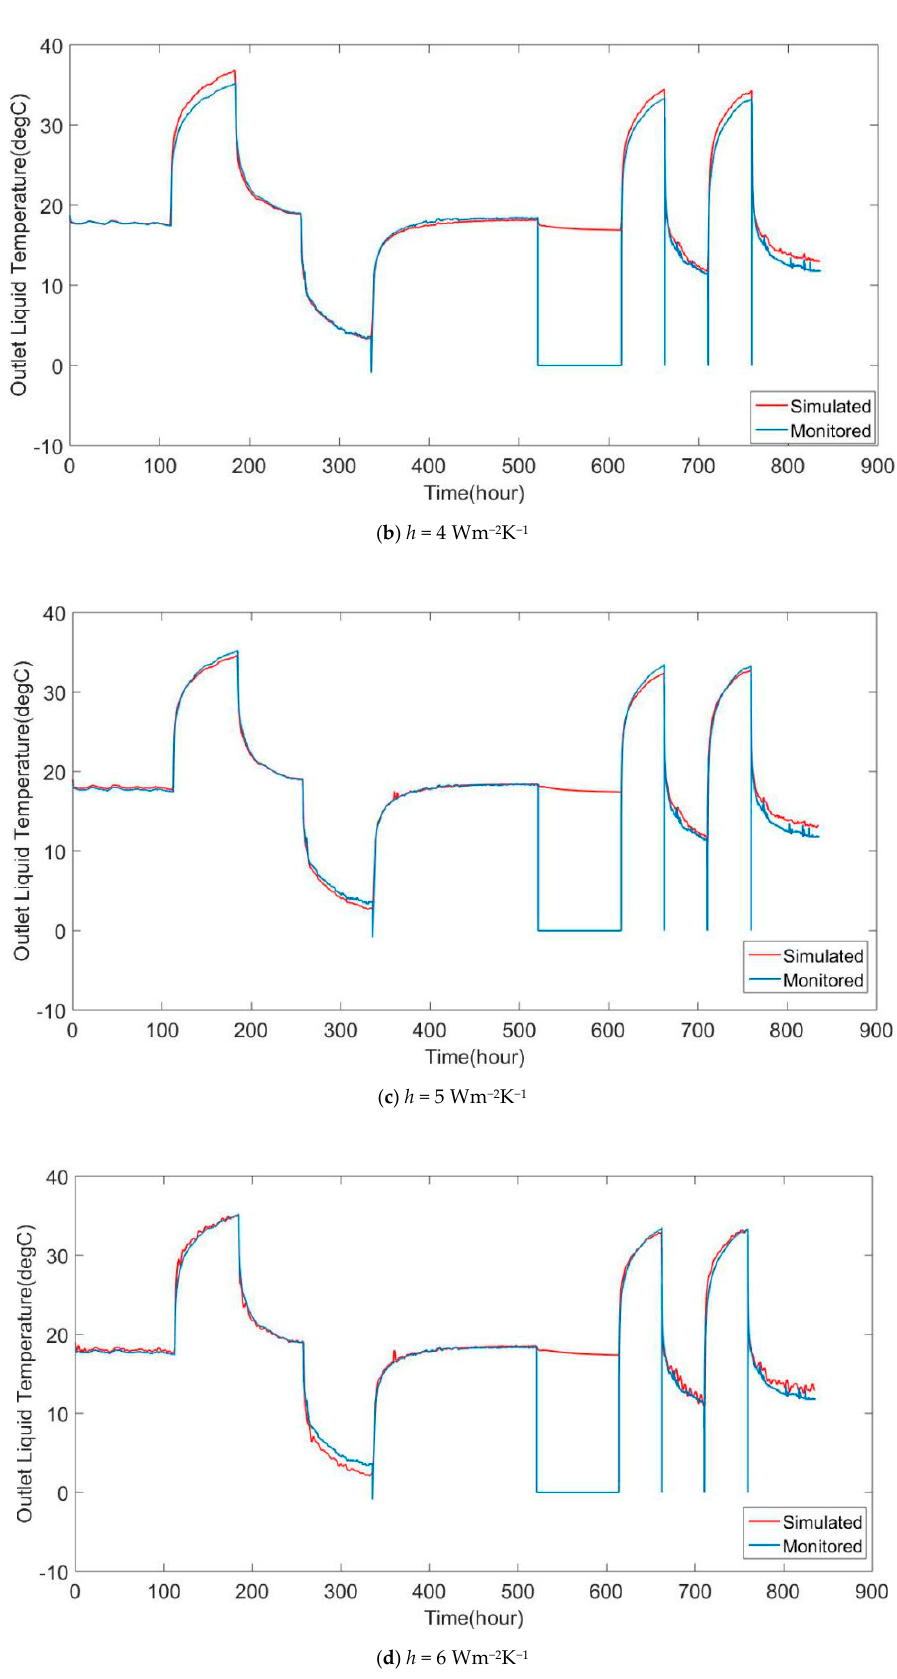
Figure 13. TRT outlet liquid temperatures when the heat transfer coefficient is adjusted.